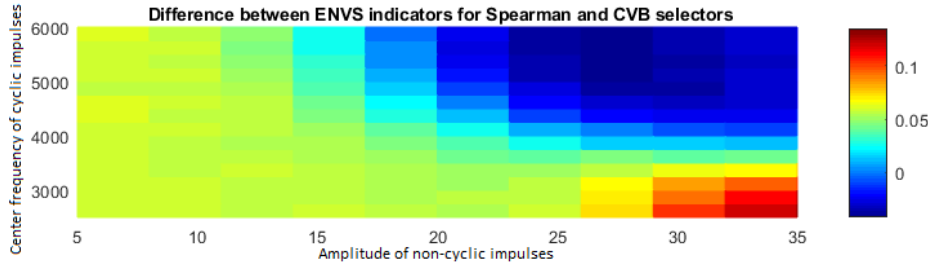
Figure 51. Difference between ENVS indicators for Spearman and CVB selectors.